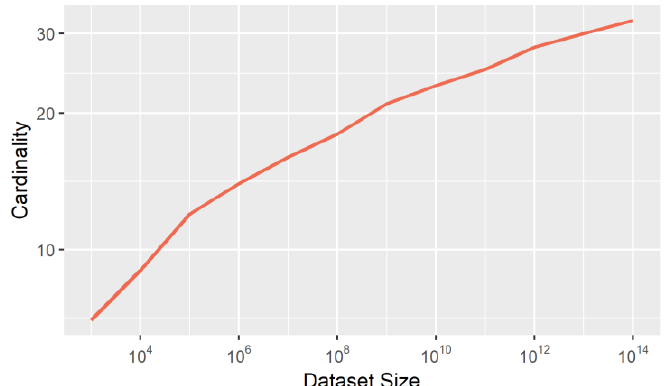
Figure 2. Cardinality of the skyline set compared to the cardinality of the dataset.